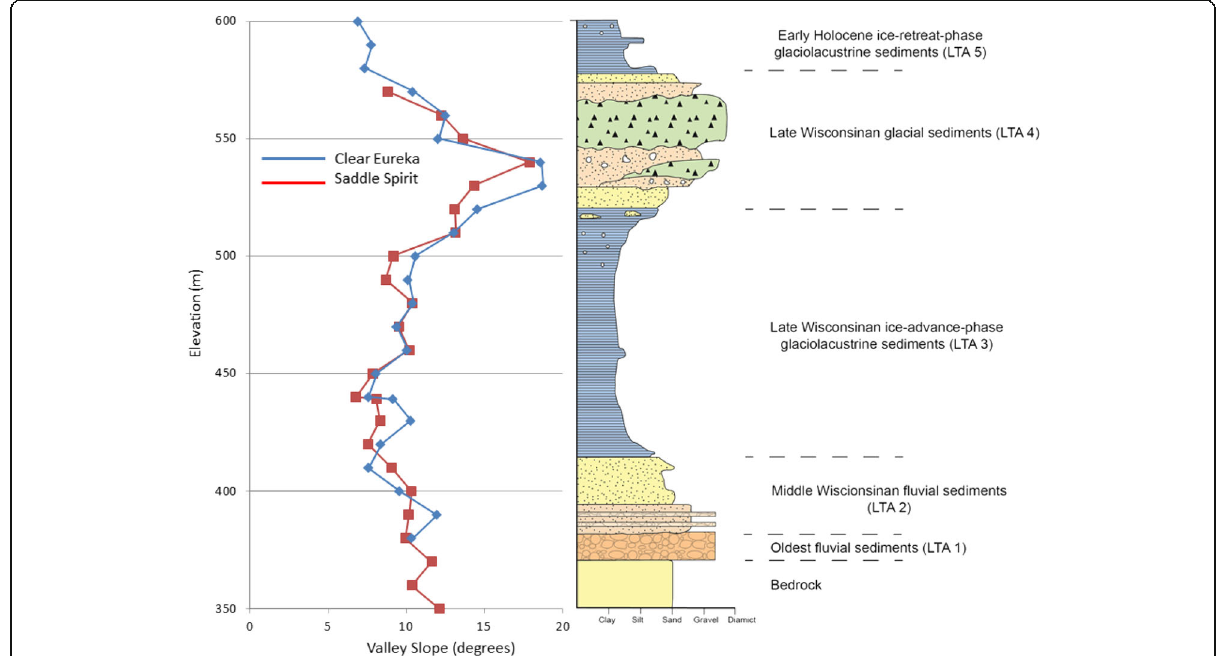
Fig. 2 Generalized stratigraphy found within buried preglacial valleys in the Peace River lowlands (right; modified after Morgan et al. 2012), and (left) average valley slopes of the lower Clear River (to the Eureka River) and the Eureka River (blue), and the lower Saddle River (to the Spirit River) and the Spirit River (red). Five of the landslides described appear be associated with ice-advance -phase glaciolacustrine sediment (LTA3), and two with the lower portion of the glacial sediments (LTA4). The valley slopes appear to reflect the stratigraphy. The slopes are lowest where the rivers are incising through LTA3 or LTA5, and steepen where the river incises into LTA4. Note that thickness of LTA4 has been exaggerated in this diagram, as the diamict is not topography constrained and will impact the valley slope response to incision over a longer distance than the unit thickness would otherwise